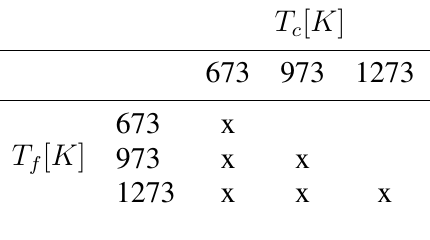
Table 1: Temperatures for Monte Carlo simulations in